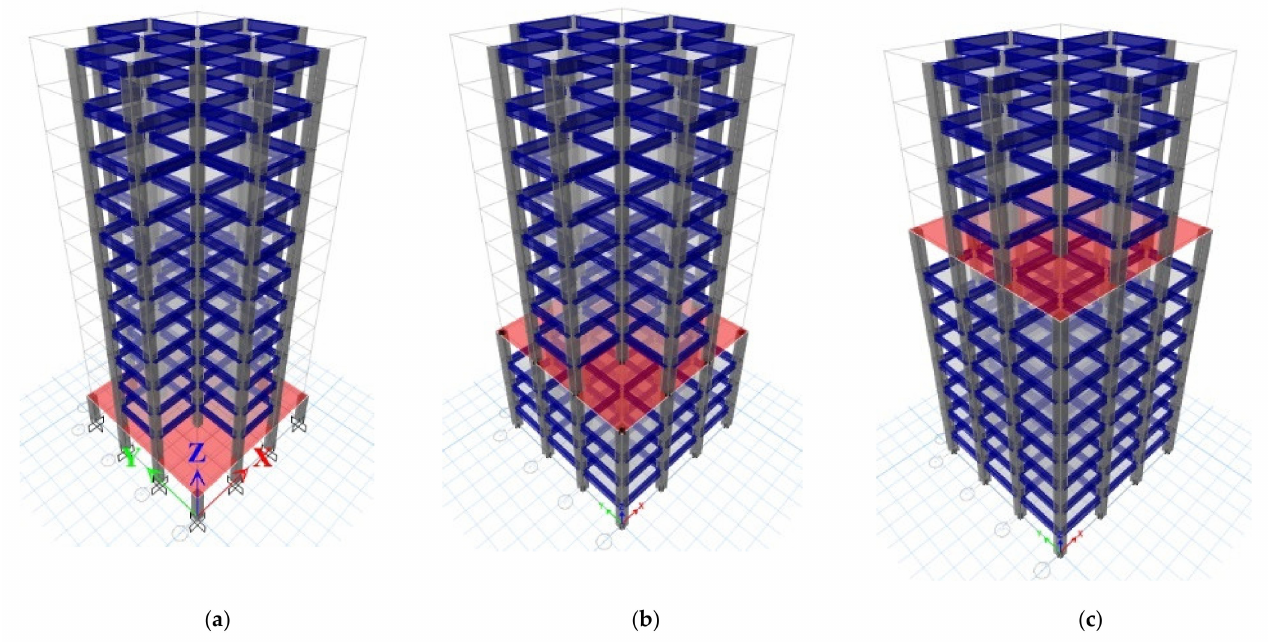
Figure 7. Combined irregularity models ( a ) slab at the first story (BC); ( b ) slab at the fourth story (MC); ( c ) slab at the eighth story